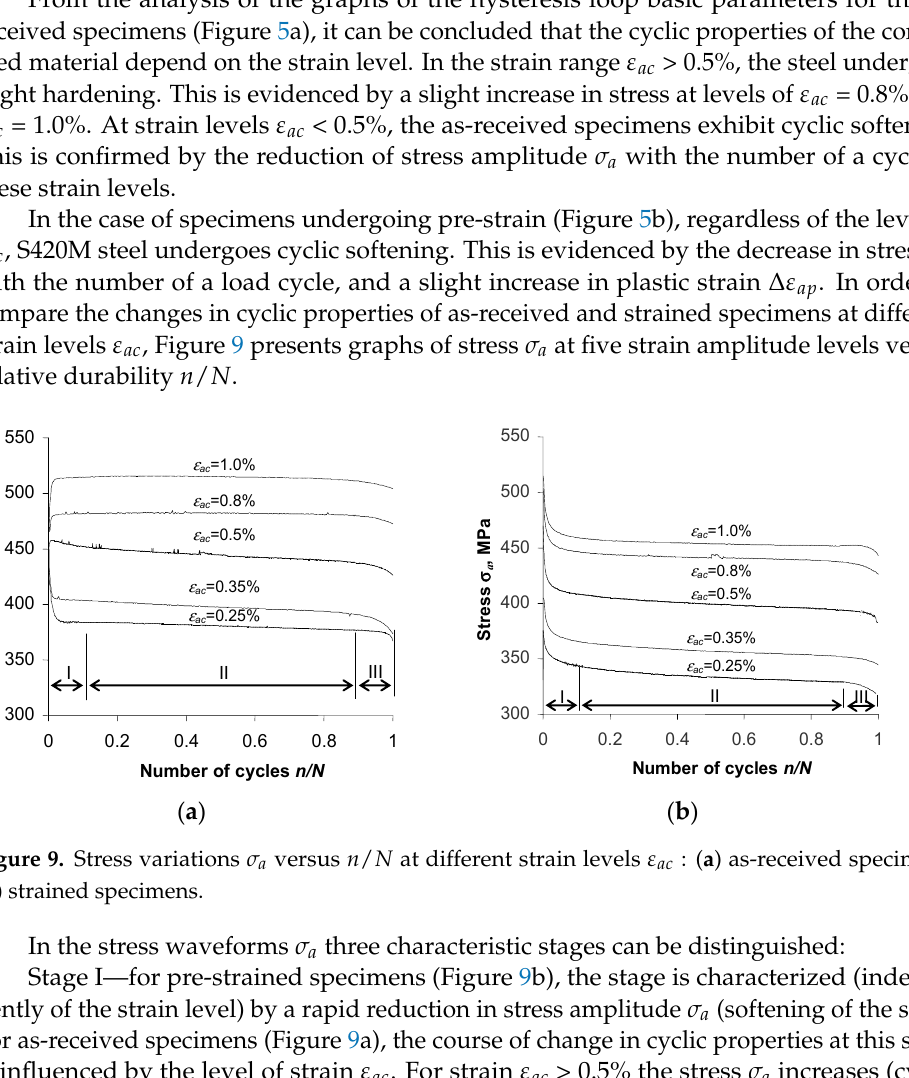
Figure 8. Influence of pre-strain on plastic strain ∆ ε ap : ( a ) ε ac = 0.25%; ( b ) ε ac = 0.5%; ( c ) ε ac = 1.0%.